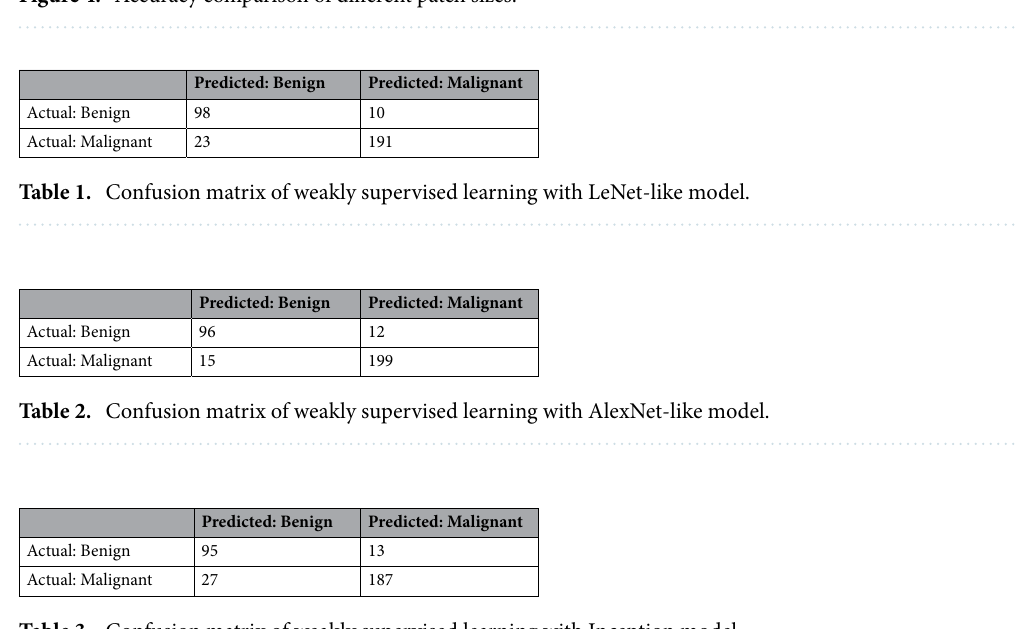
Figure 4. Accuracy comparison of different patch sizes.